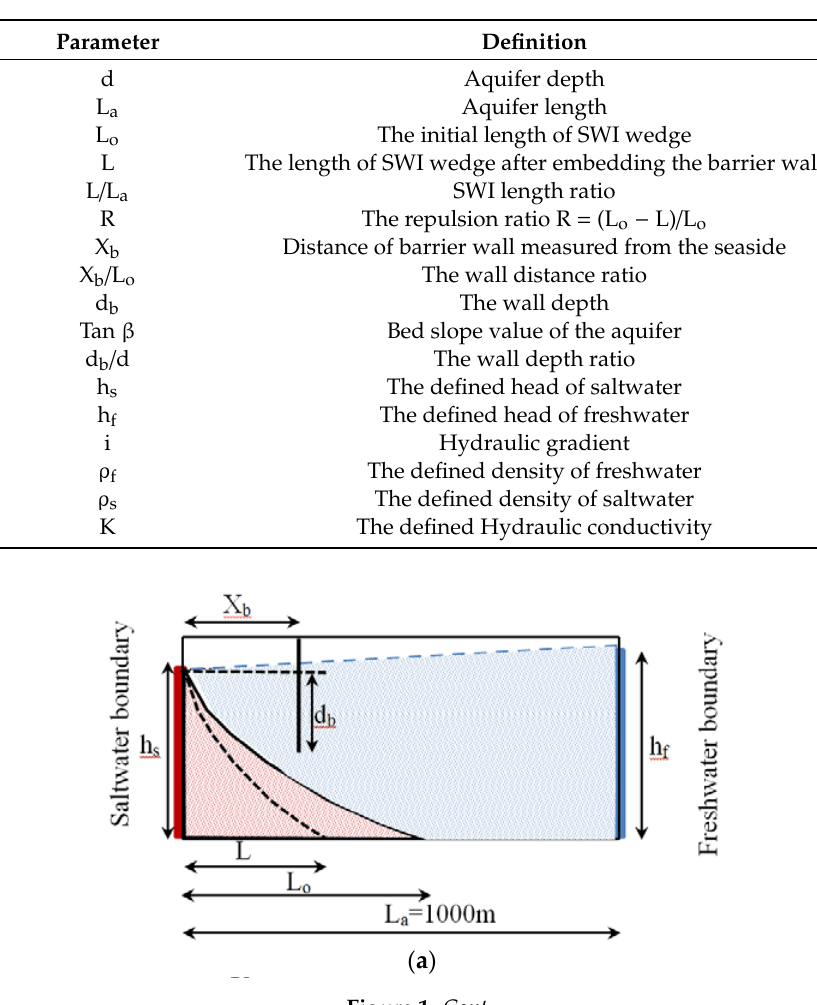
Table 1. Parameter definitions.